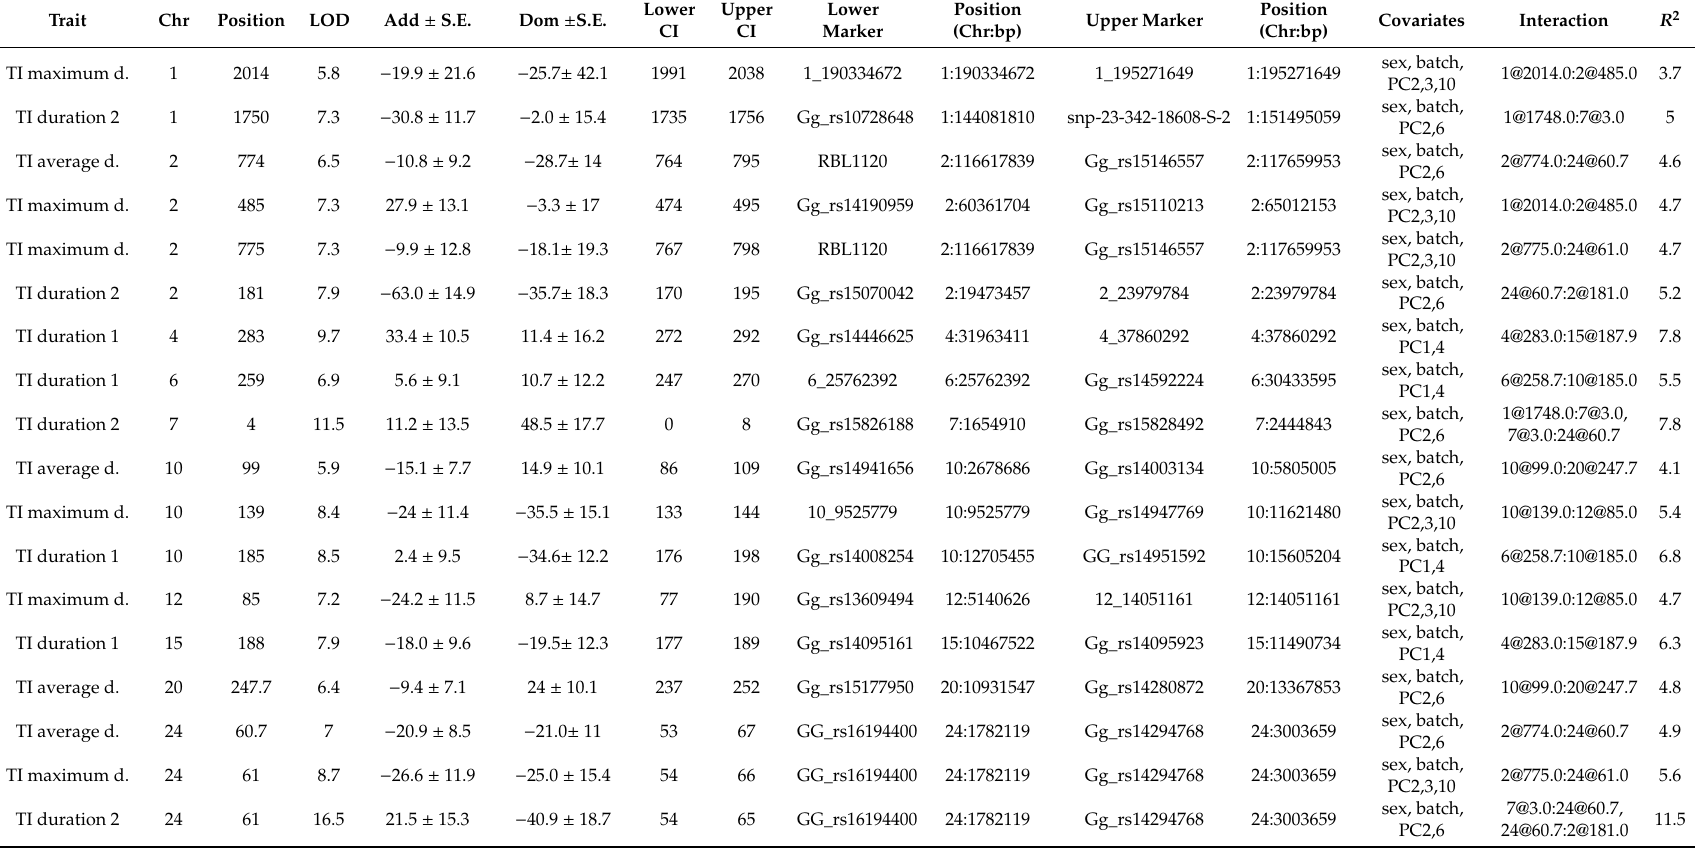
Table 1. Tonic Immobility (TI) quantitative trait loci (QTL) identified in the main mapping population. Chromosome, position (in cM and chr:bp), additive and dominance e ff ects, lower and upper confidence intervals (CI), as well as covariates used and any epistatic interactions incorporated are provided, as is the total variance explained by each QTL ( r -squared) and the nearest genetic marker to the upper and lower C.I. Traits are maximum time spent in tonic immobility (TI maximum d.), average time spent in tonic immobility (TI average d.), time spent in tonic immobility in trial 1 (TI duration 1) and time spent in tonic immobility in trial 2 (TI duration